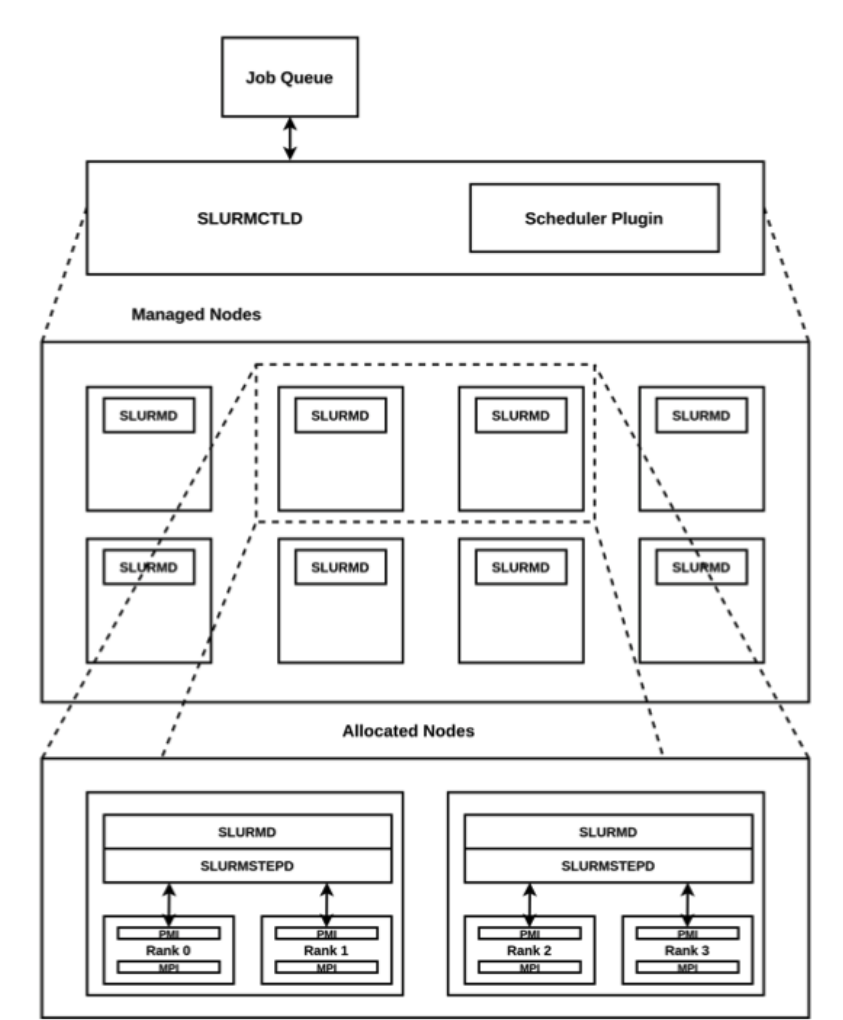
Figure 2. Elastic MPI—overview of the interactions between the SLURM daemons [21]. Source: https://mediatum.ub.tum.de/doc/1539159/file.pdf (accessed on 7 May 2022). Reprinted with permission from [21]. Copyright 2020, Mohak